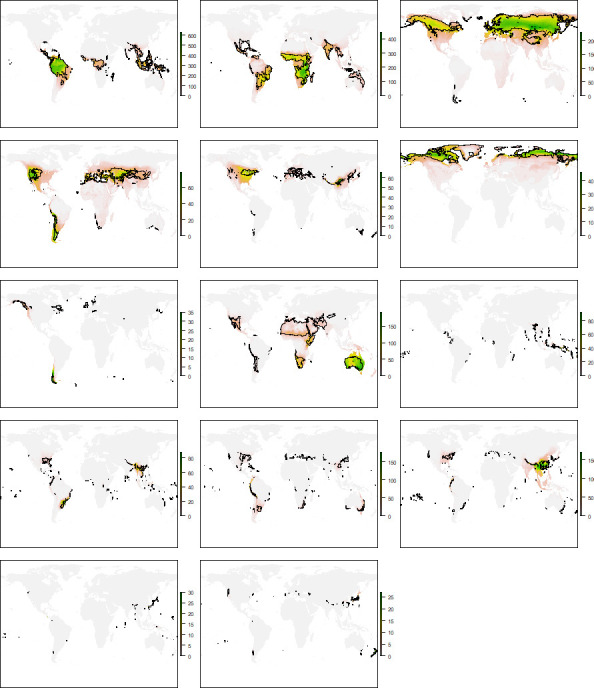
Distribution of the climatic conditions (black line) and the species (colored richness values) belonging to the same niche domains of birds.